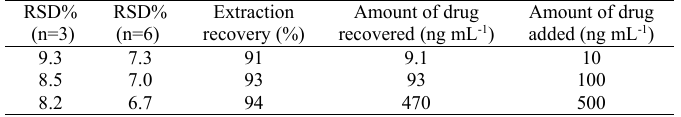
Table 2. recovery and repeatablity of the experiments for trace determination of phenytoin in plasma samples